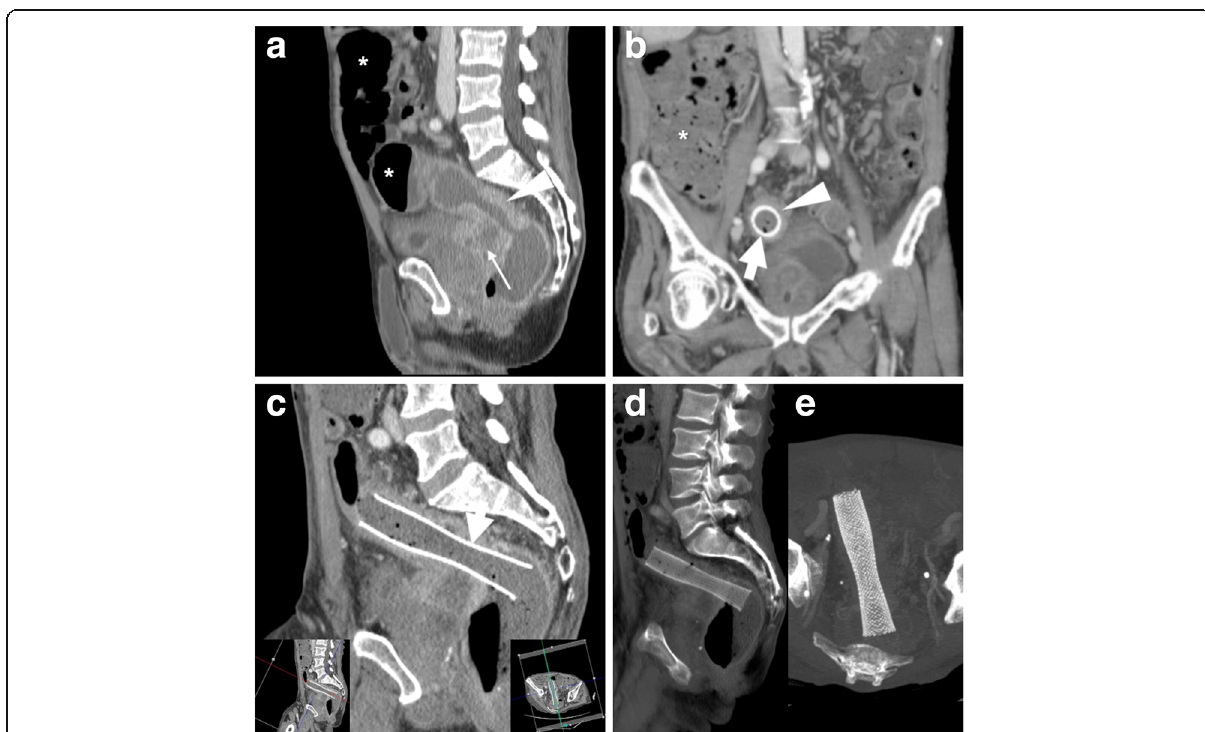
Fig. 3 Palliation of unresectable CRC and dedicated CT reconstruction techniques. In an elderly male, sagittal contrast-enhanced CT ( a ) shows a 6-cm-long segment with enhancing, non-stratified increased mural thickness (arrowhead) at the rectosigmoid junction, causing luminal stricture and upstream large bowel obstruction (LBO*) complicated by fistulisation (thin arrow) to the prostate and urinary bladder. After endoscopic stenting, repeated CT ( b , c ) including focused oblique images (note obliquity in c insets) effectively depicted the correct position of the SEMS (thick arrows) at the site of CRC (arrowheads), filled with faecal fluid with partial persistence of upstream colonic dilatation (*). Additional thick- slab ( d ) and maximum-intensity projection (MIP) reconstructions depict the tubular shape and reticular “ mesh ” structure of the well-expanded